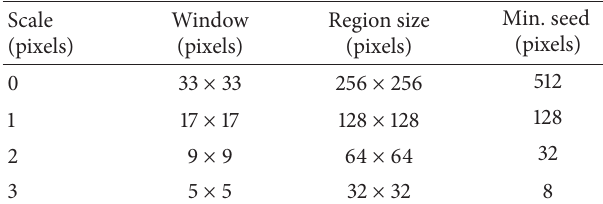
Table 1: Parameter set for different